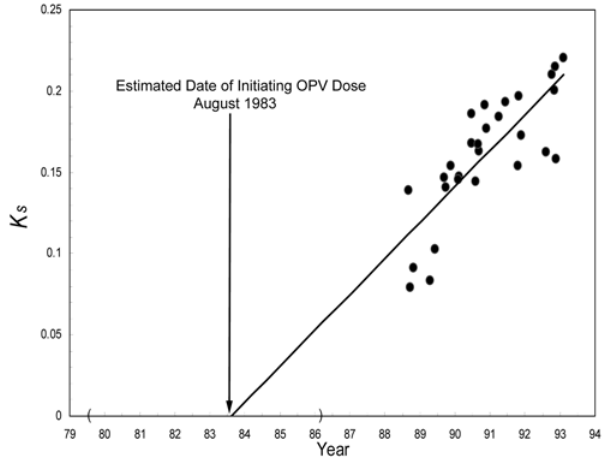
Figure 6 . ( From: Yang et al, JVirol 2003; 77:8366–8377) Estimate of the date of initiating OPV dose from the rate of accumu- lation of synonymous substitutions into VP1 among the 28 type 2 cVDPV isolates for which the dates of sample collection are known. Abscissa: date of sample collection for each isolate. Ordinate: Ks , the number of substitutions (Sabin 2 sequence set to zero substitutions) at synonymous sites in VP1. The evolution rate was estimated by weighted linear regression. The 95% CI for the estimated date of the initiating OPV dose, July 1979 to March 1986, is bounded by parentheses along the abscissa.